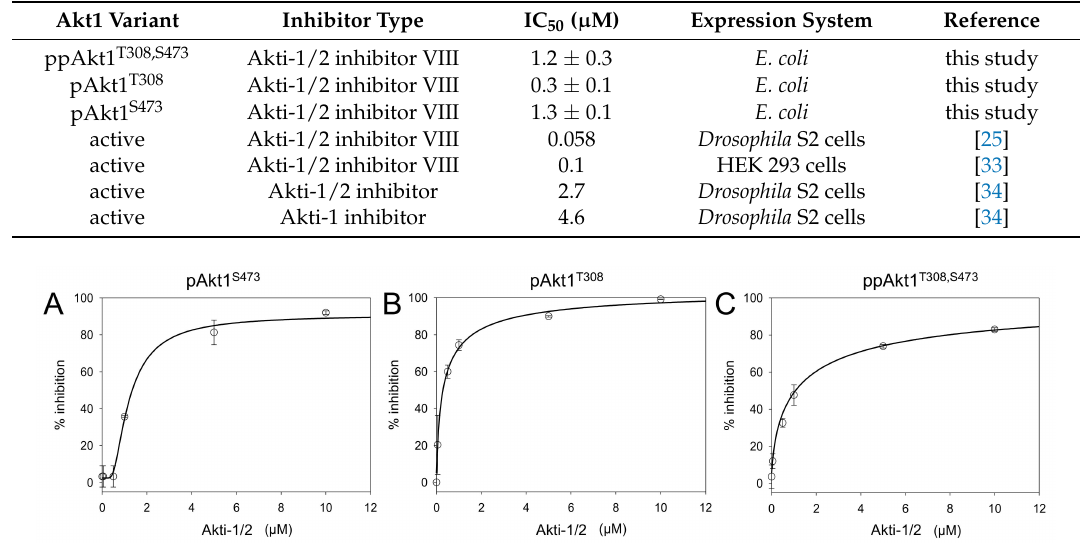
Figure 7. Chemical inhibition of full-length phosphorylated Akt1 variants. Inhibition of ( A ) pAkt1 S473 , ( B ) pAkt1 T308 , and ( C ) ppAkt1 T308,S473 with varying concentrations (0.001, 0.05, 0.5, 1, 5, 10 µ M) of Akti-1/2 inhibitor VIII. The resulting IC 50 values are in Table